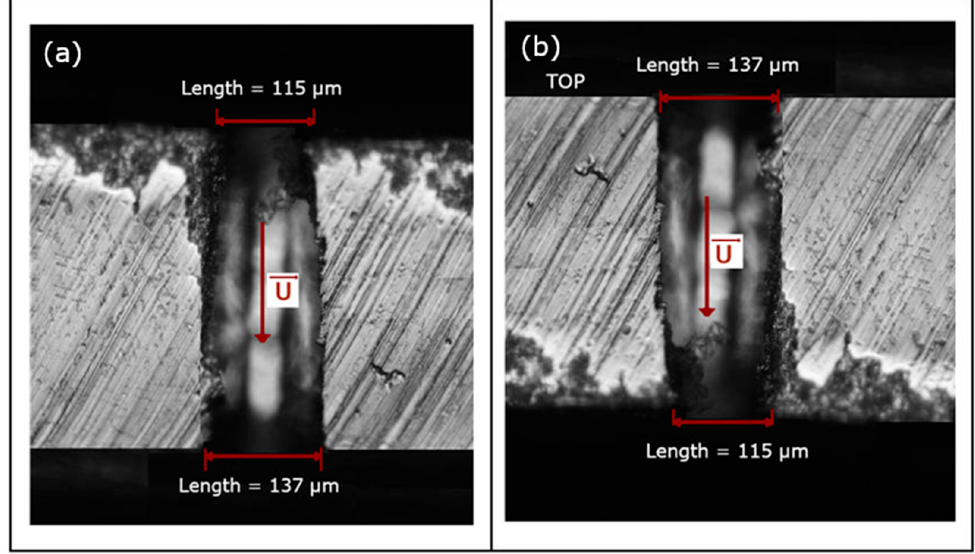
Figure 4. Shape of the hole channel with the velocity direction for the basic ( a ) and reversed ( b ) plate setting; plate K1.